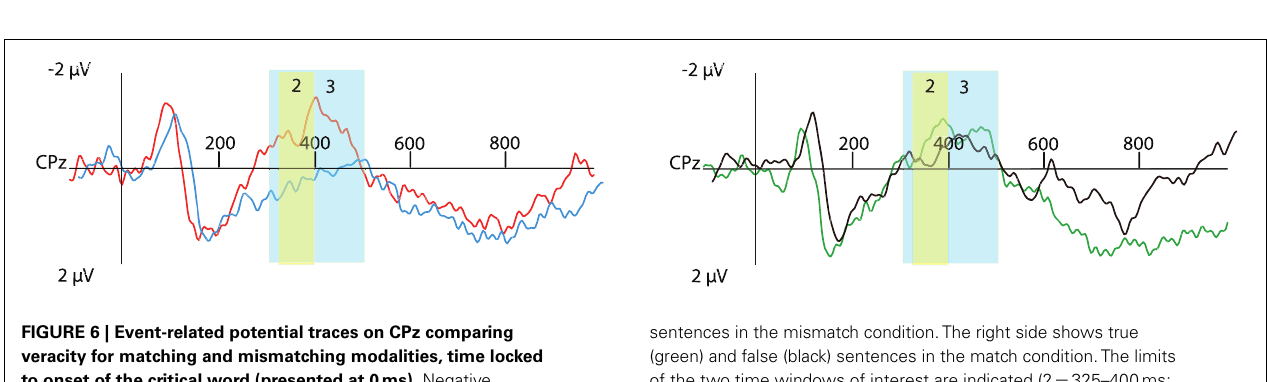
FIGURE 6 | Event-related potential traces on CPz comparing veracity for matching and mismatching modalities, time locked to onset of the critical word (presented at 0ms). Negative activation is plotted up.The left side shows true (red) and false (blue)